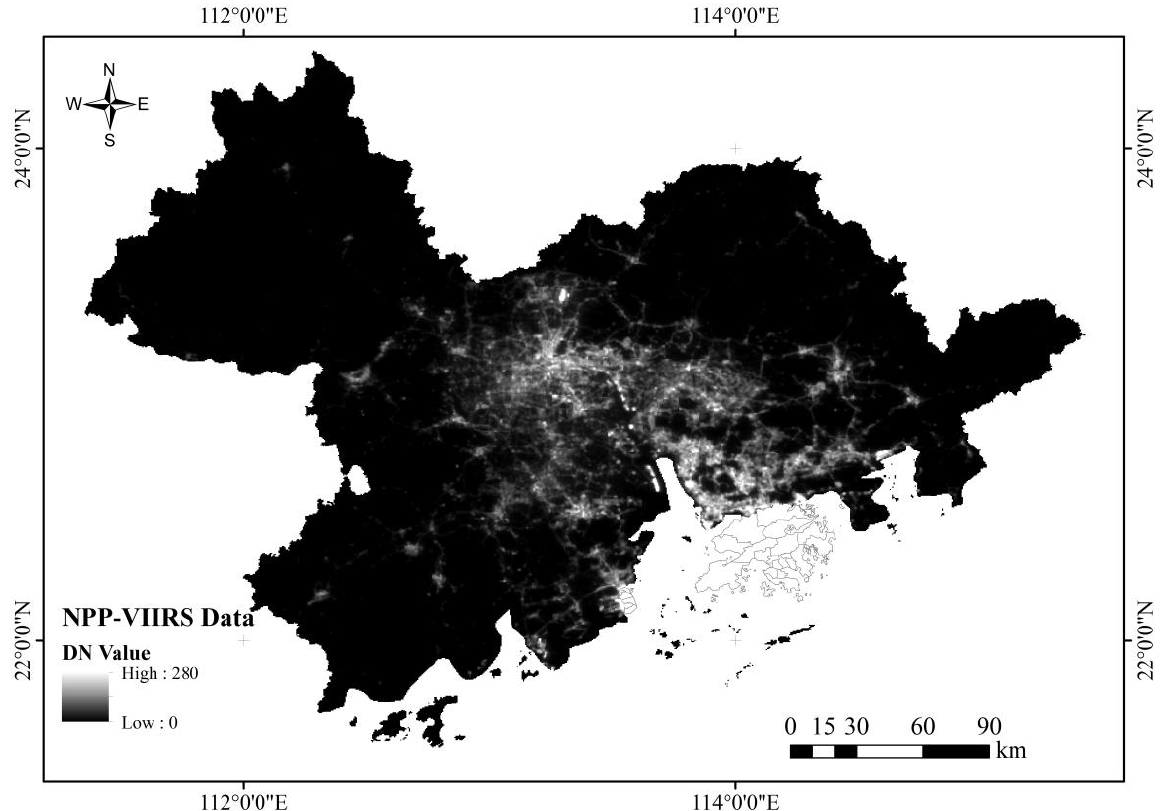
Figure 2. NPP-VIIRS nighttime light data of the Pearl River Delta in 2017.